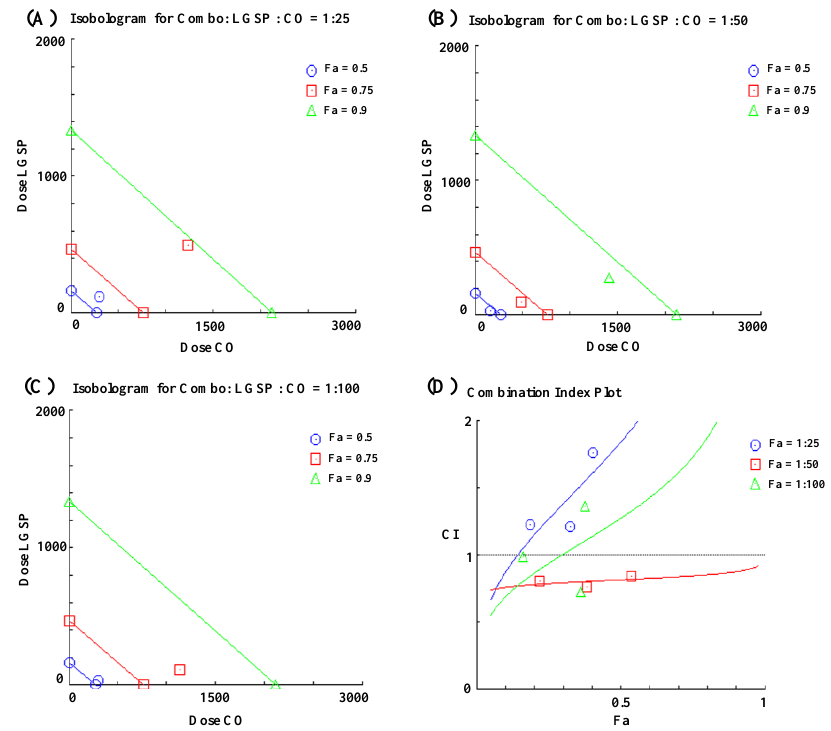
Figure 3. Isobologram curves for the combination of LGSP and CO in ratios of 1:25 ( A ), 1:50 ( B ) and 1:100 ( C ) on inhibition of NO production. Combination index (CI) for LGSP and CO on inhibition of NO production in LPS-stimulated RAW264.7 cells ( D ).